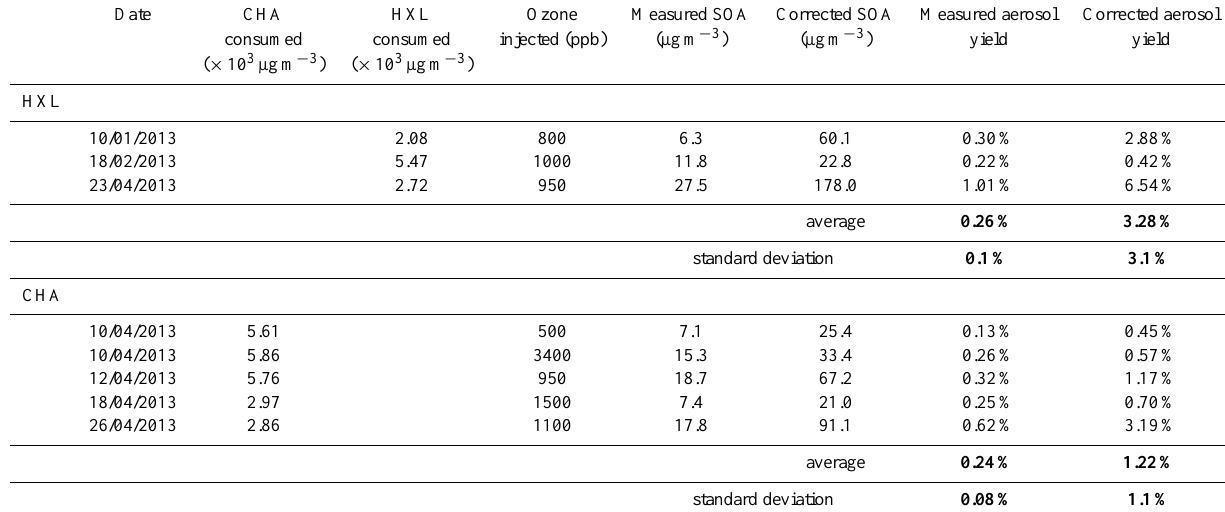
Table 1. Experimental conditions and SOA yields for several GLV standard ozonolysis experiments, used to determine average aerosol yield for GLVs. Corrected SOA accounts for aerosol wall loss (Eq. S1 and Fig. S5 in the Supplement) and was used .to determine the average corrected SOA yield for CHA and HXL, 1.2 ( ± 1.1)% and 3.3 ( ± 3.1)% respectively, as indicated by the bolded text below.